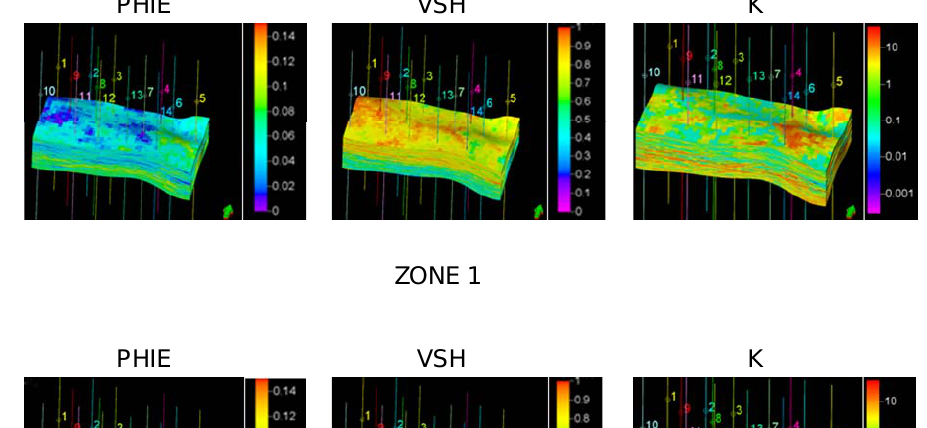
Fig. 8. Fractal distributions of effective porosity (PHIE), shale volume (VSH) and permeability (K) for zones 3 and 4.